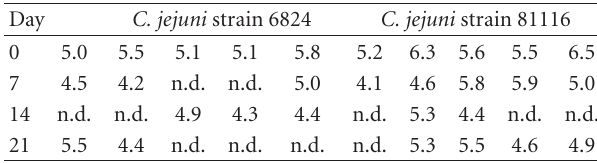
Table 1: Campylobacter jejuni cells detected on spinach shoot